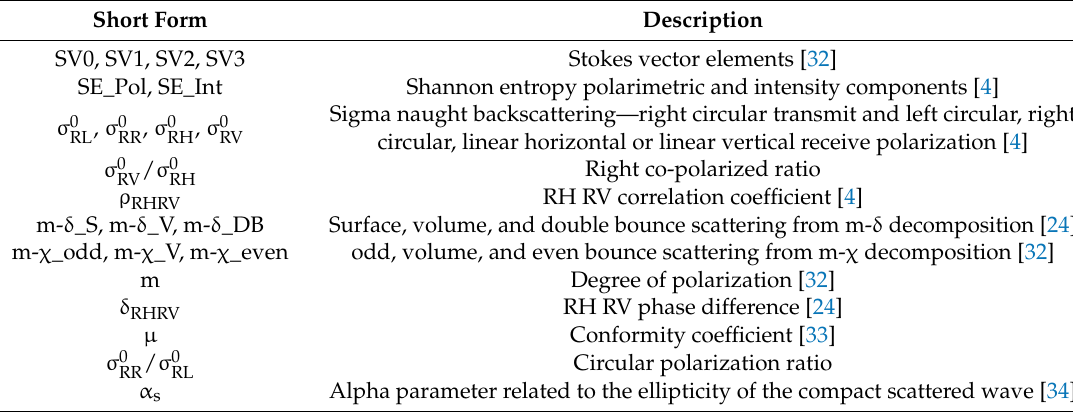
Table 2. Assessed Compact Polarimetric (CP) parameters of the RADARSAT Constellation Mission (RCM) High Resolution (HR) mode. Short Form Description SV0, SV1, SV2, SV3 Stokes vector elements [32] SE_Pol, SE_Int Shannon entropy polarimetric and intensity components [4] Sigma naught backscattering—right circular transmit and left circular, right σ 0 , σ 0 , σ 0 , σ 0 RL RR RH RV circular, linear horizontal or linear vertical receive polarization [4] σ 0 Right co-polarized ratio / σ 0 RV RH ρ RHRV RH RV correlation coefficient [4] m- δ _S, m- δ _V, m- δ _DB Surface, volume, and double bounce scattering from m- δ decomposition [24] m- χ _odd, m- χ _V, m- χ _even odd, volume, and even bounce scattering from m- χ decomposition [32] m Degree of polarization [32] δ RHRV RH RV phase difference [24] µ Conformity coefficient [33] σ 0 Circular polarization ratio / σ 0 RR RL α s Alpha parameter related to the ellipticity of the compact scattered wave